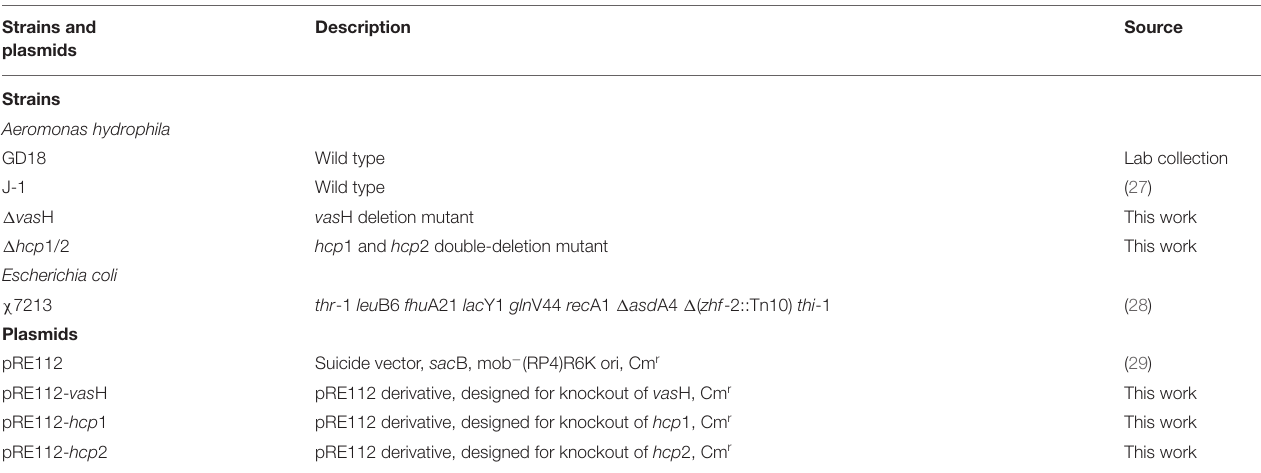
TABLE 1 | Strains and plasmids used in this